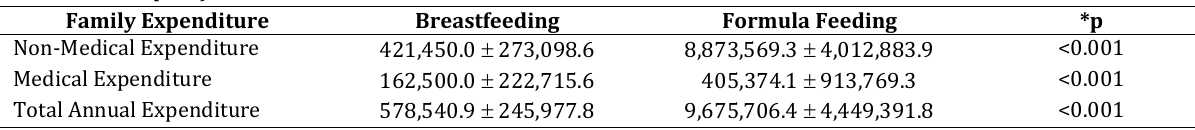
Table 4. Illness History